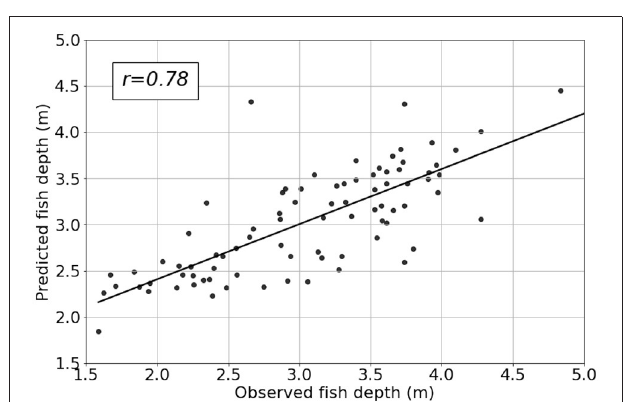
FIGURE 8 | Scatter plot of model predicted fish depth plotted against observed values for the CAN site. Inputs to the model are environmental data time-aligned with the target data, and hour of day to represent temporal variations (which Figure 7 suggested to be an important contributor to fish